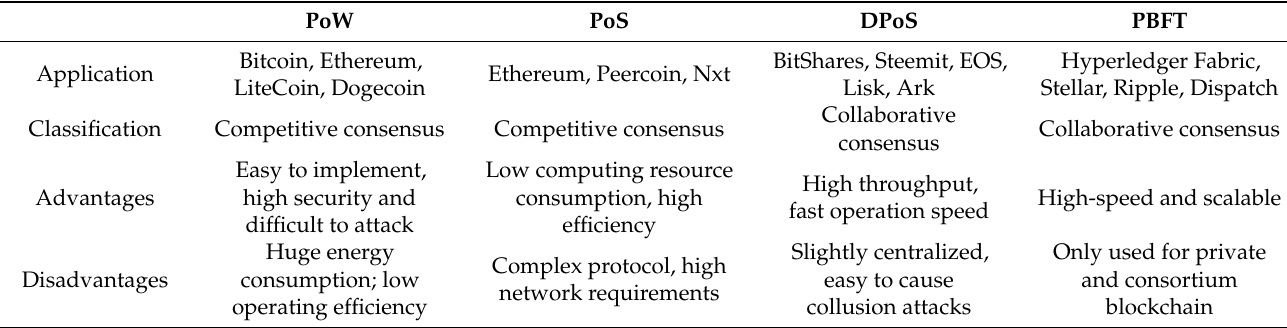
Table 1. Comparison of common consensus